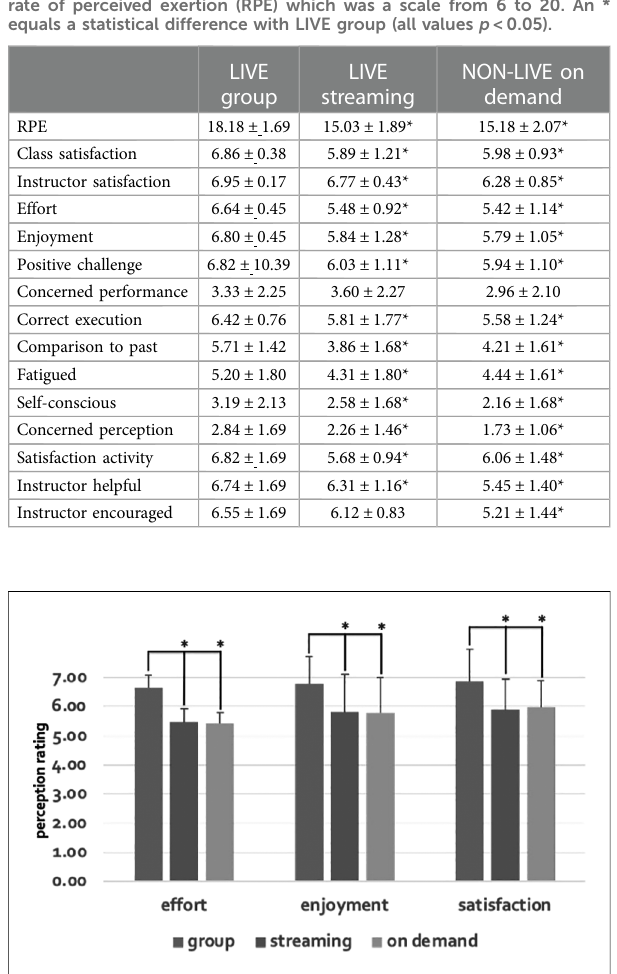
FIGURE 3 Mean class effort, enjoyment, and satisfaction during the live group format compared to both live streaming and on demand. An * equals a statistical difference with live group (all values p <0.001). However, the participants were more self-conscious and concerned about their performance during the live group format.